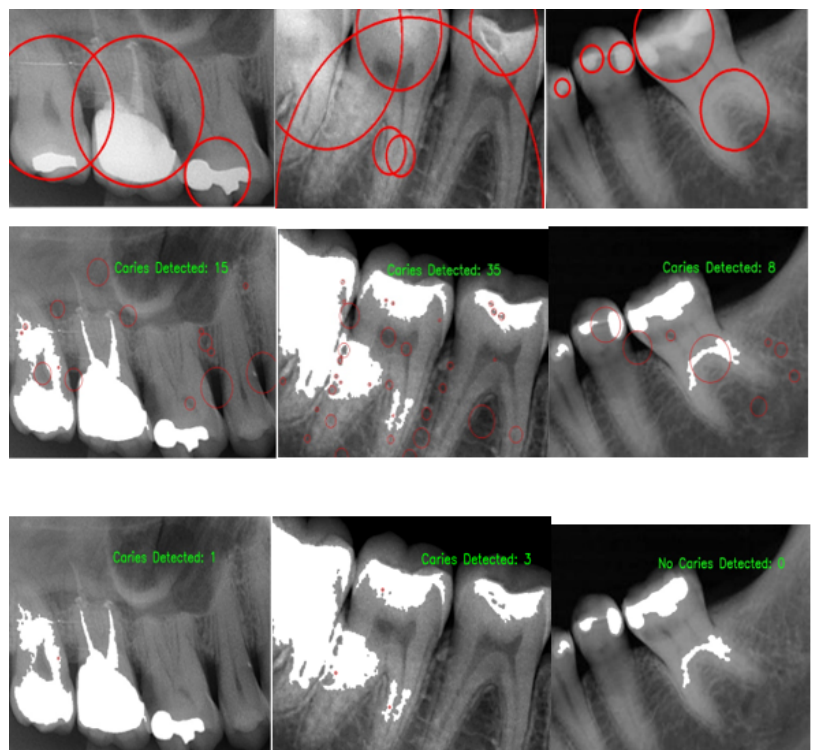
Figure 3. First Row : Teeth boundary detection via active contours method. Second Row : All blobs detected on masked images. Third Row : Caries detected blobs on masked